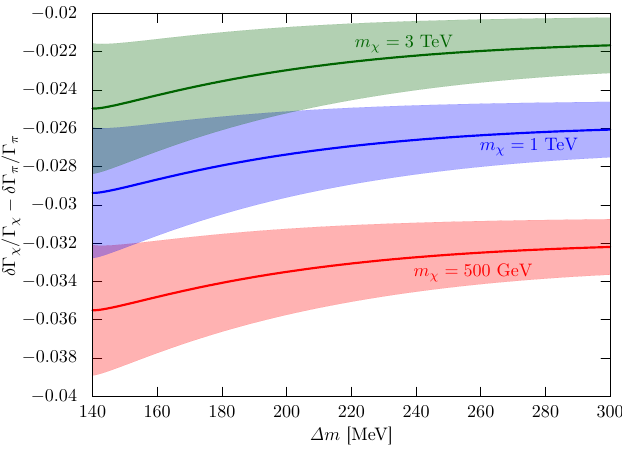
Figure 16 . The radiative correction to the ratio of the decay rate, δ Γ χ / Γ χ − δ Γ π / Γ π , as a function of ∆ m . Each band corresponds to the error of NLO analysis which is dominated by the uncertainties of the MRM. For the pure Wino case, the mass differences ranges in ∆ m ' 163 – 165 MeV for m χ > 600 GeV